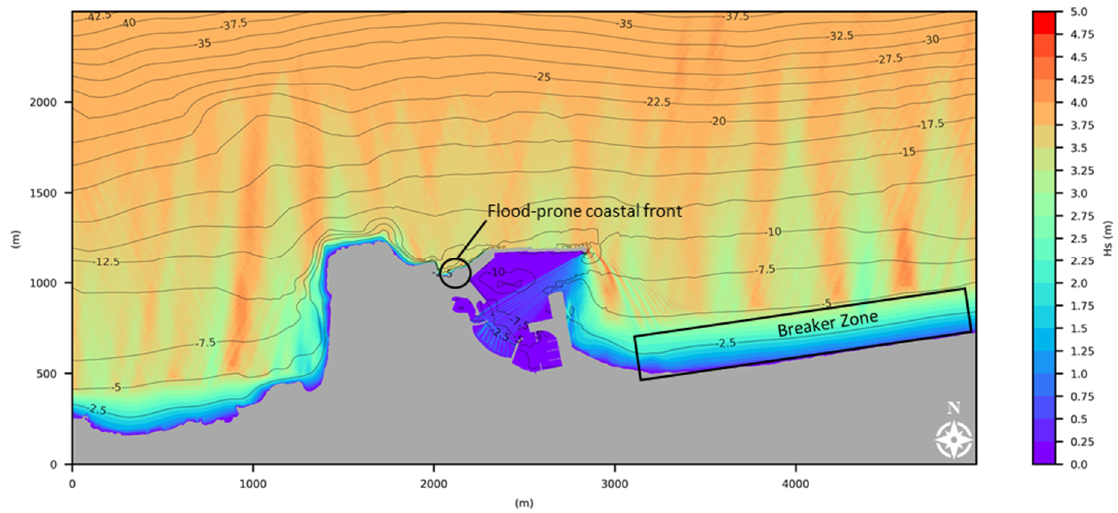
Figure 4. Simulation results of spatial distribution of nearshore wave heights (indicated by color palette) for the flood event in 10 December 2010; contours indicate sea water depths.